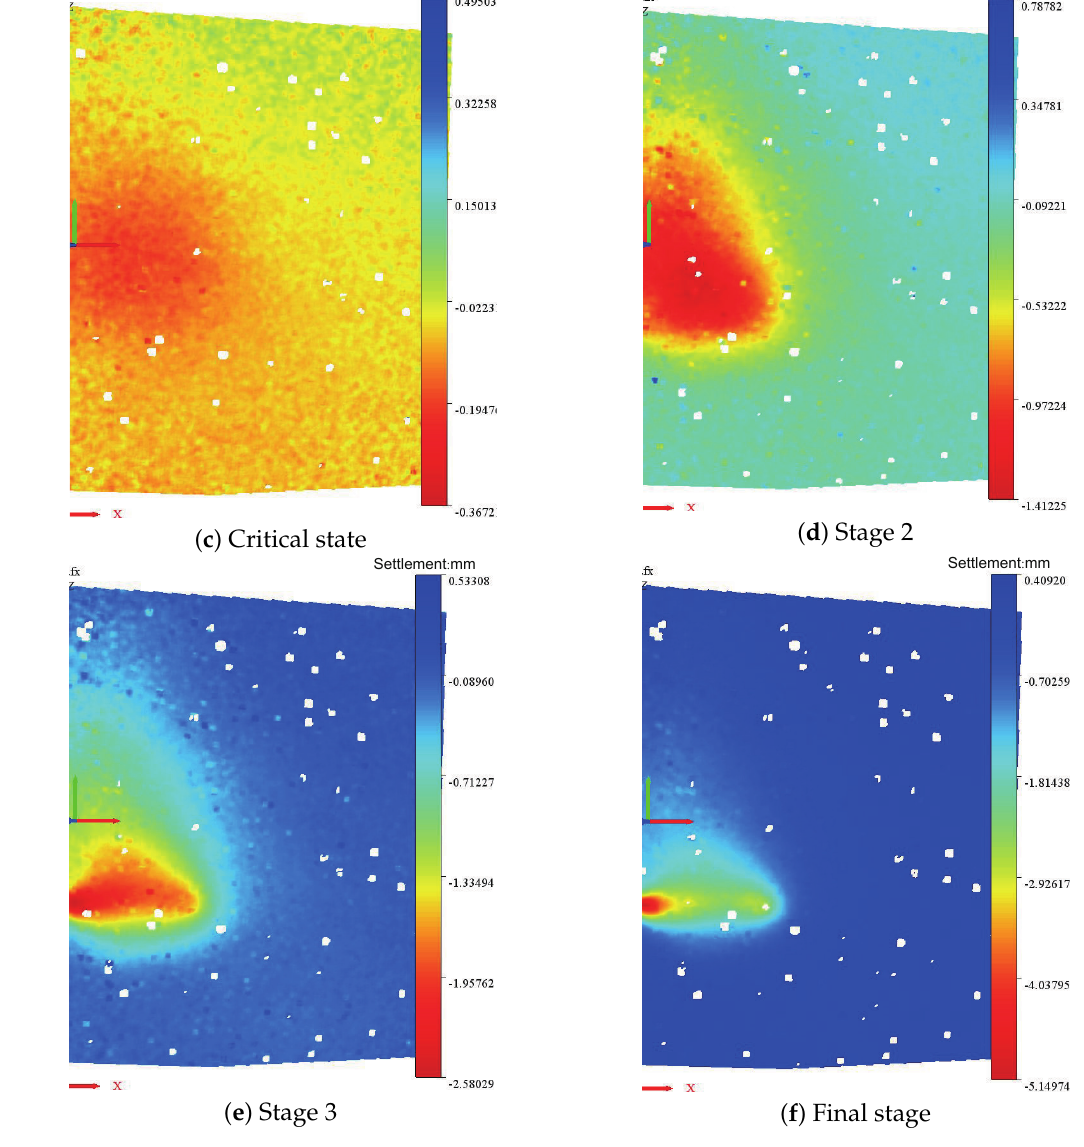
Figure 11. 3D maps of the surface settlement with the pipe roof, EI = 1.0; C / D =